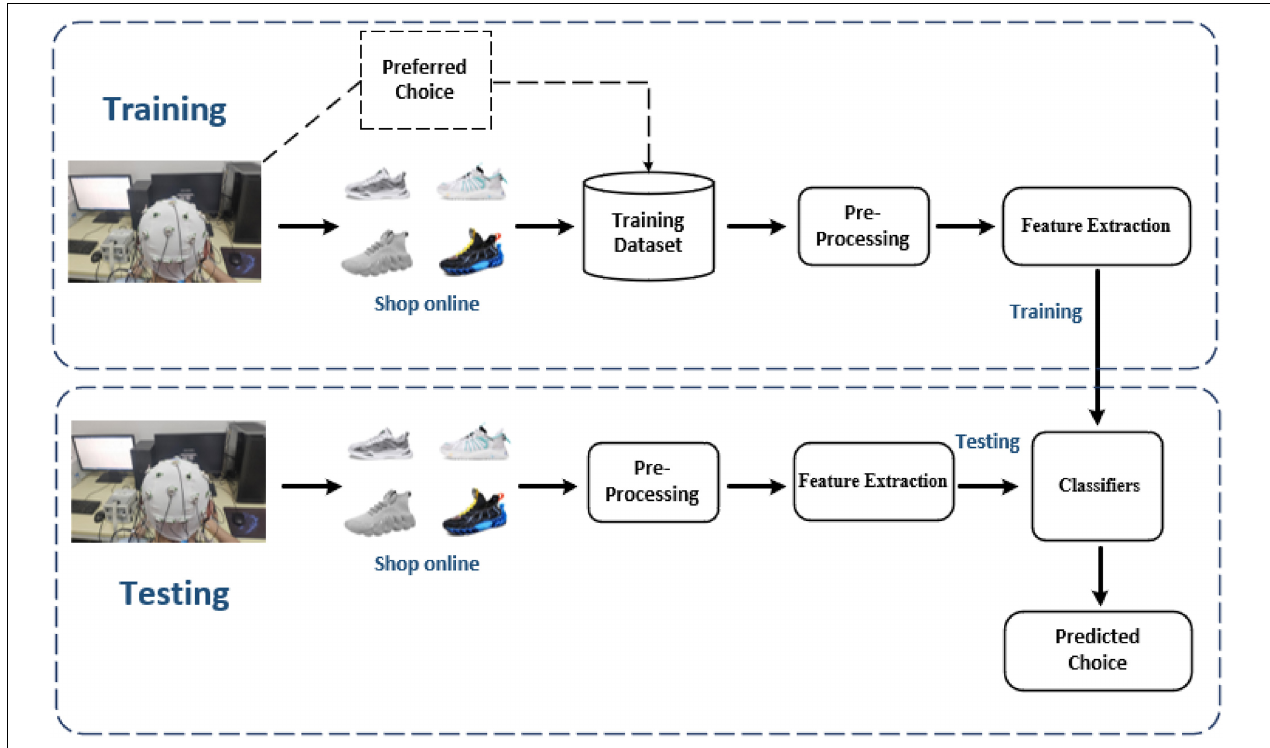
FIGURE 3 | Flow chart of the proposed electroencephalography (EEG)-based consumer’s preference prediction model.